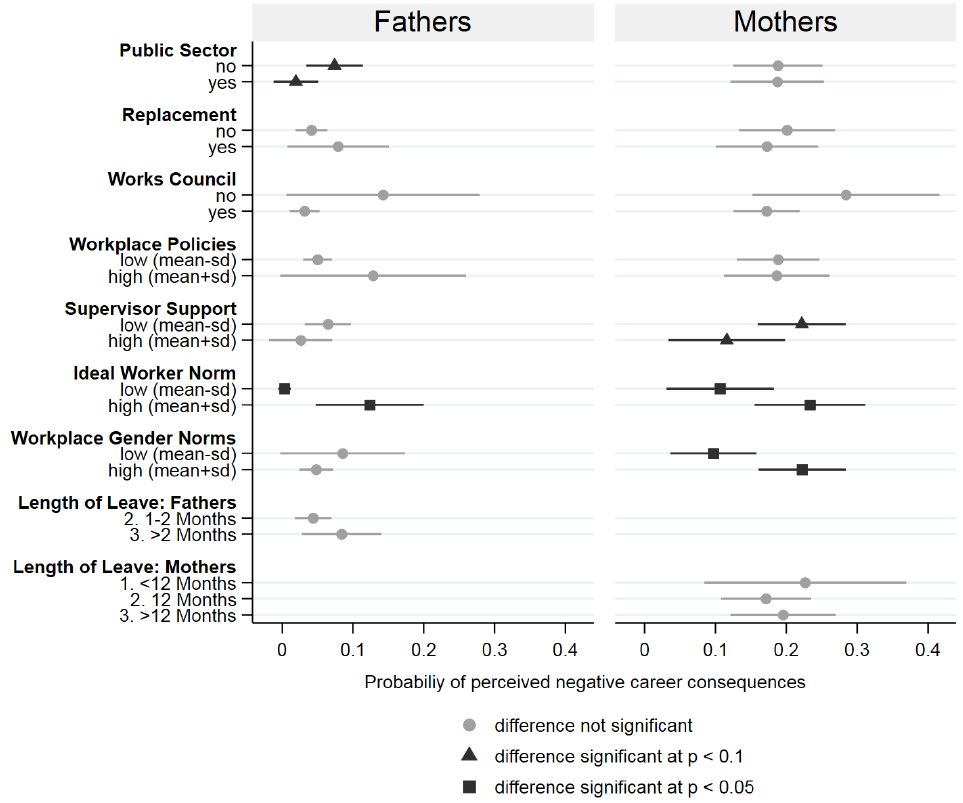
Figure 5. Predicted margins of parents’ likelihood of perceiving negative career consequences.